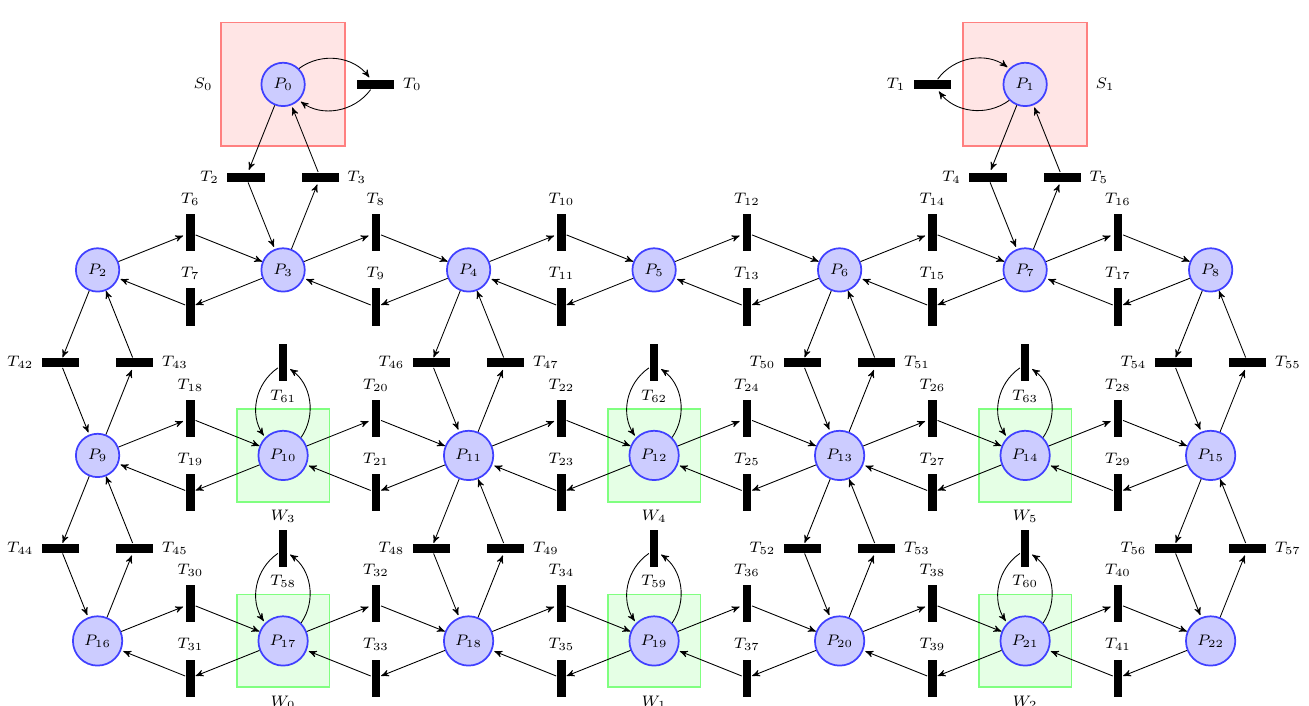
Figure 3. Petri net model of the manufacturing facility.